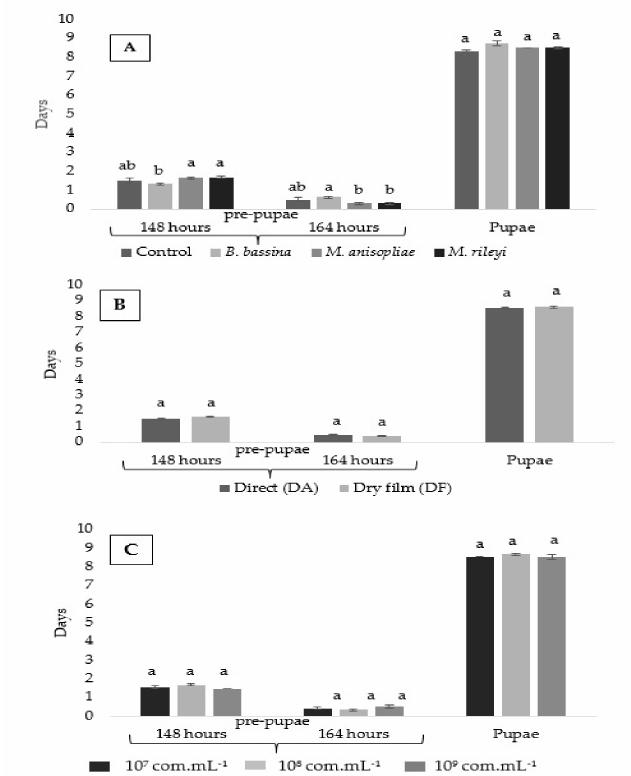
Figure 3. Average number (mean ± standard error) of the duration of pre-pupae and pupae of Chrysoperla externa after application of the entomopathogenic fungi Beauveria bassiana , Metarhizium anisopliae and Metarhizium rileyi (T: 25 ± 1 ◦ C, RH of 70 ± 10% and photoperiod of 12 h (light / dark)). Duration in days for each stage according to factors: ( A ) product, ( B ) method of application and ( C ) concentrations. Means followed by equal letters at each assessment time do not di ff er from each according to a Tukey test at 5%